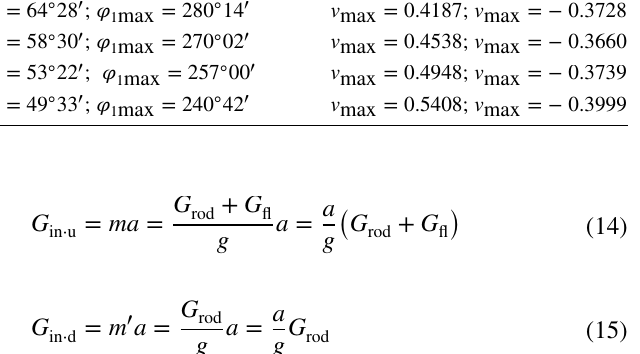
Table 1 The value of the maximum speed of the rods suspension point at the corresponding angles of rotation of the crank, depending on the dimensionless parameters 𝜆 and